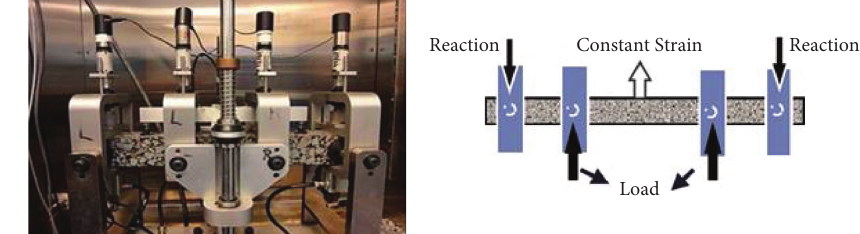
Figure 3: Schematic of the FPB fatigue